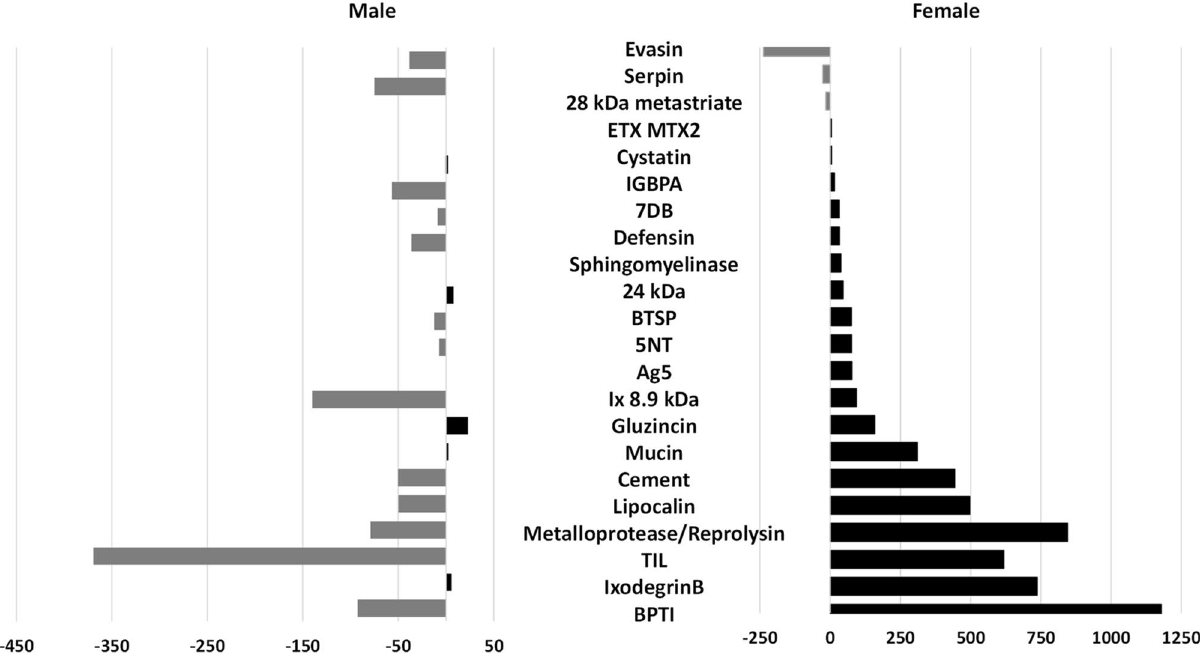
Figure 8. Differentially expressed secretory proteins in the male and female transcriptome with the highest significance as related to fold change over time compared to protein abundance as counts. Positive log2 fold changes are indicative of upregulation while negative log2 fold changes indicate